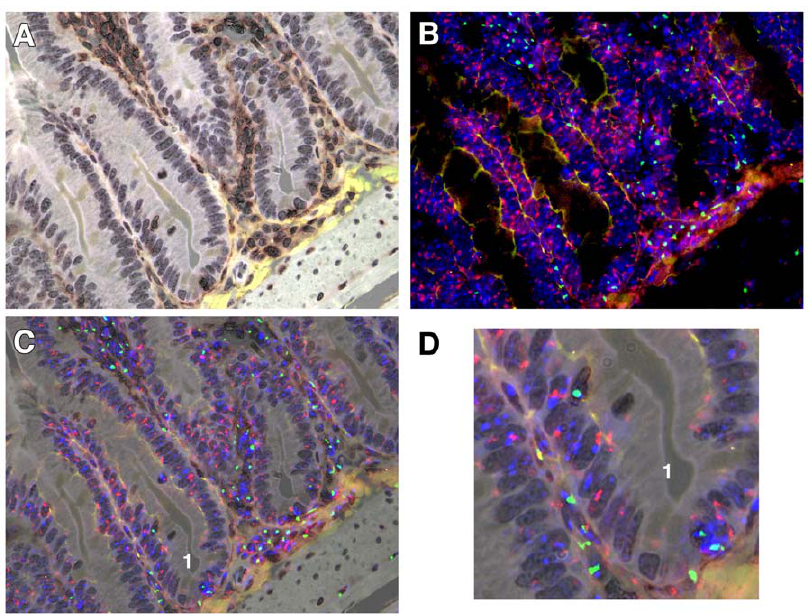
Figure 3. Combined CD45 IHC with XY chromosome paints. A. Female Rag2 2 / small intestine stained with 3 layer IHC for CD45 and revealed with DAB (brown), with light haematoxylin nuclear counterstain. B. Same section probed sequentially for X (red) and Y (green) chromosomes, with nuclei additionally stained with DAPI (blue). Note background fluorescence (yellow-orange) yielding some tissue morphology. C. Overlay image of A and B revealing crypts containing several possible male epithelial cells (No 1). D. Enlarged image of portion of C. Note male cells apposed to crypt base, and also within the epithelial layer, the latter being CD45 positive. A–C 200X, D digitally enlarged to 400X.